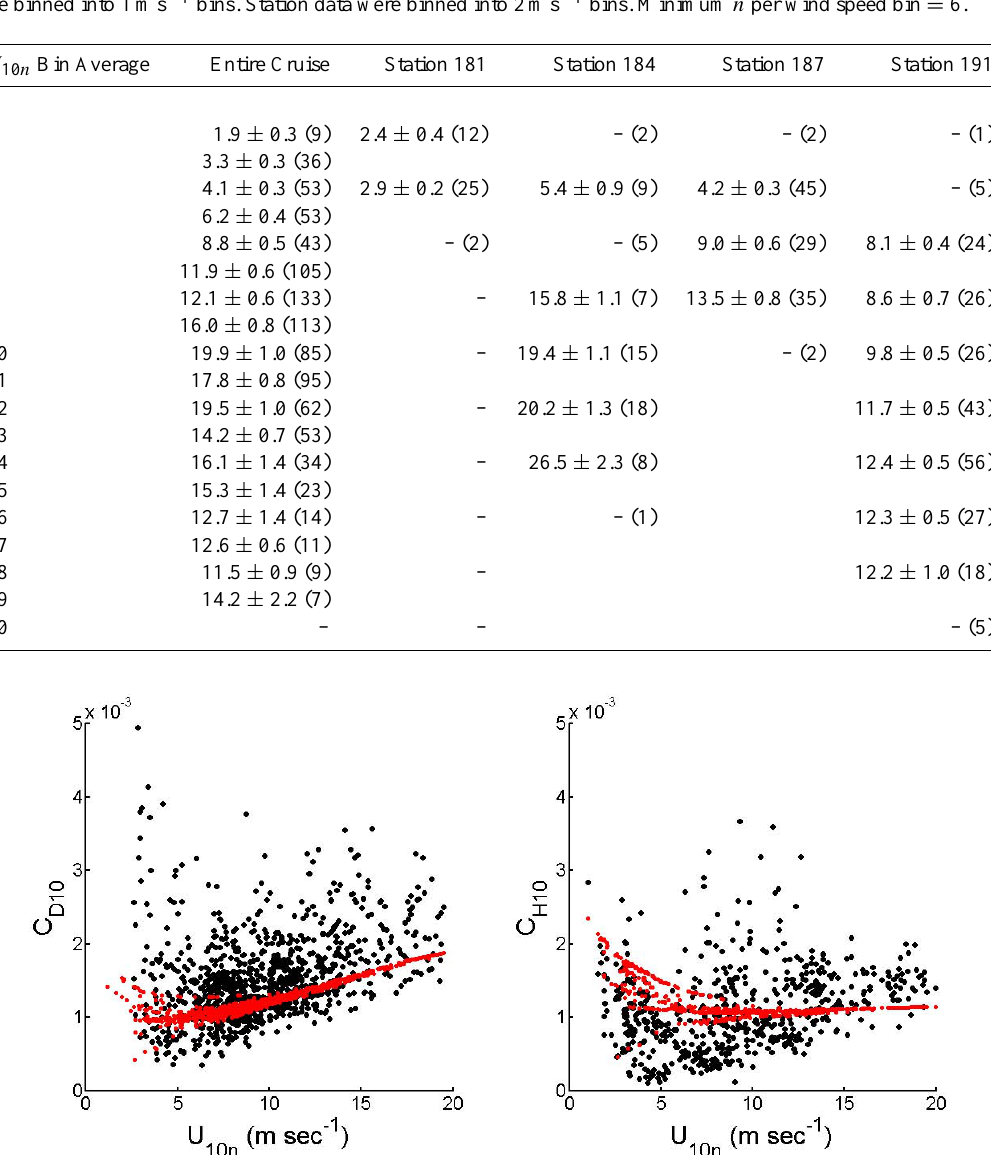
Table 1. Average (mean) k 660 values for U 10 n bins. Error bars represent ± one standard error, number of data points ( n) is in brackets. Entire cruise data were binned into 1ms − 1 bins. Station data were binned into 2ms − 1 bins. Minimum n per wind speed bin = 6.